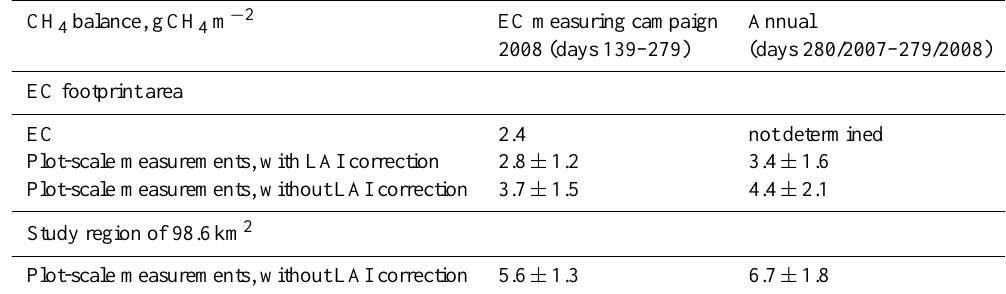
Table 3. Methane balance of the eddy covariance (EC) tower footprint area and the whole study region of 98.6km 2 based on EC and area- integrated plot-scale measurements. For the EC tower footprint area, chamber fluxes were corrected to account for the higher LAI on fen measurement plots (see text for more details on why such a correction was